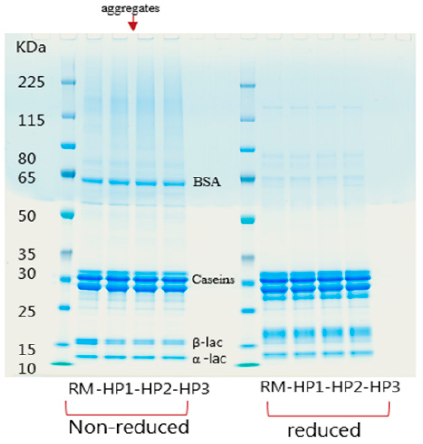
Figure 1. SDS-PAGE gel electrophoresis of raw milk (RM) and high-pressure processing (HPP)- treated milks at three conditions—400 MPa 15 min (HP1), 600 MPa 5 min (HP2) and HP 600MPa 15 min (HP3)—under non-reducing and reducing conditions before in vitro